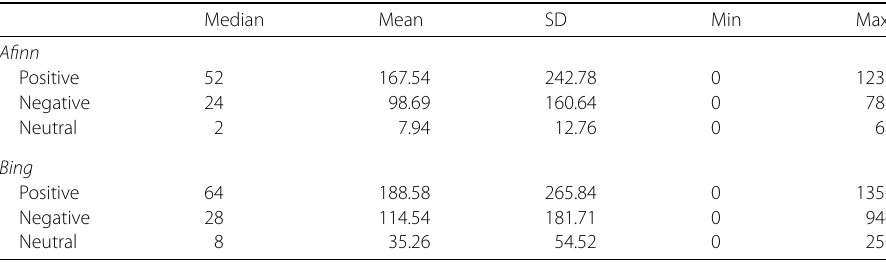
Table 4 Number of Tweets by Afinn and Bing Sentiment Score, Innovation Panel Median Mean SD Min